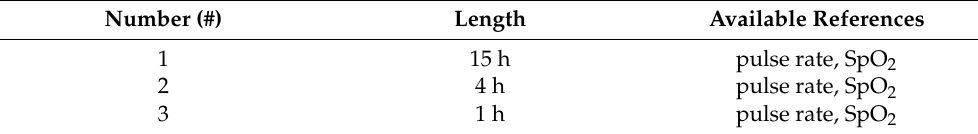
Table 2. The training (#2), validation (#3), and test (#1) datasets used for the pulse network.